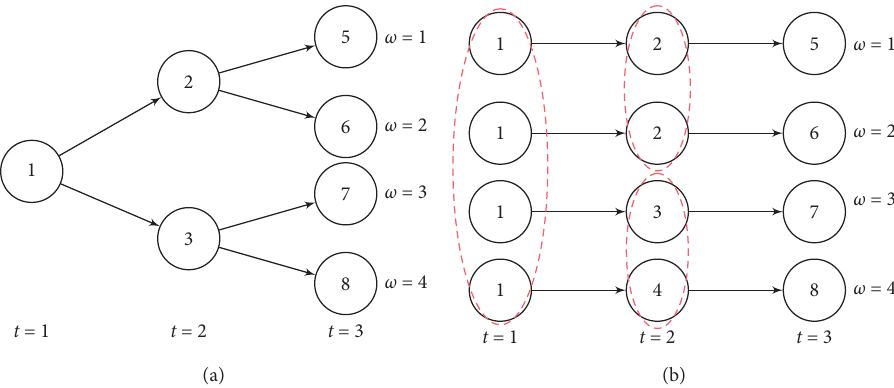
Figure 5: Scenario tree of the problem for proof of the PH with direct variable fixation failure when there is uncertainty in the volumes. Standard representation (a) and detached form representation